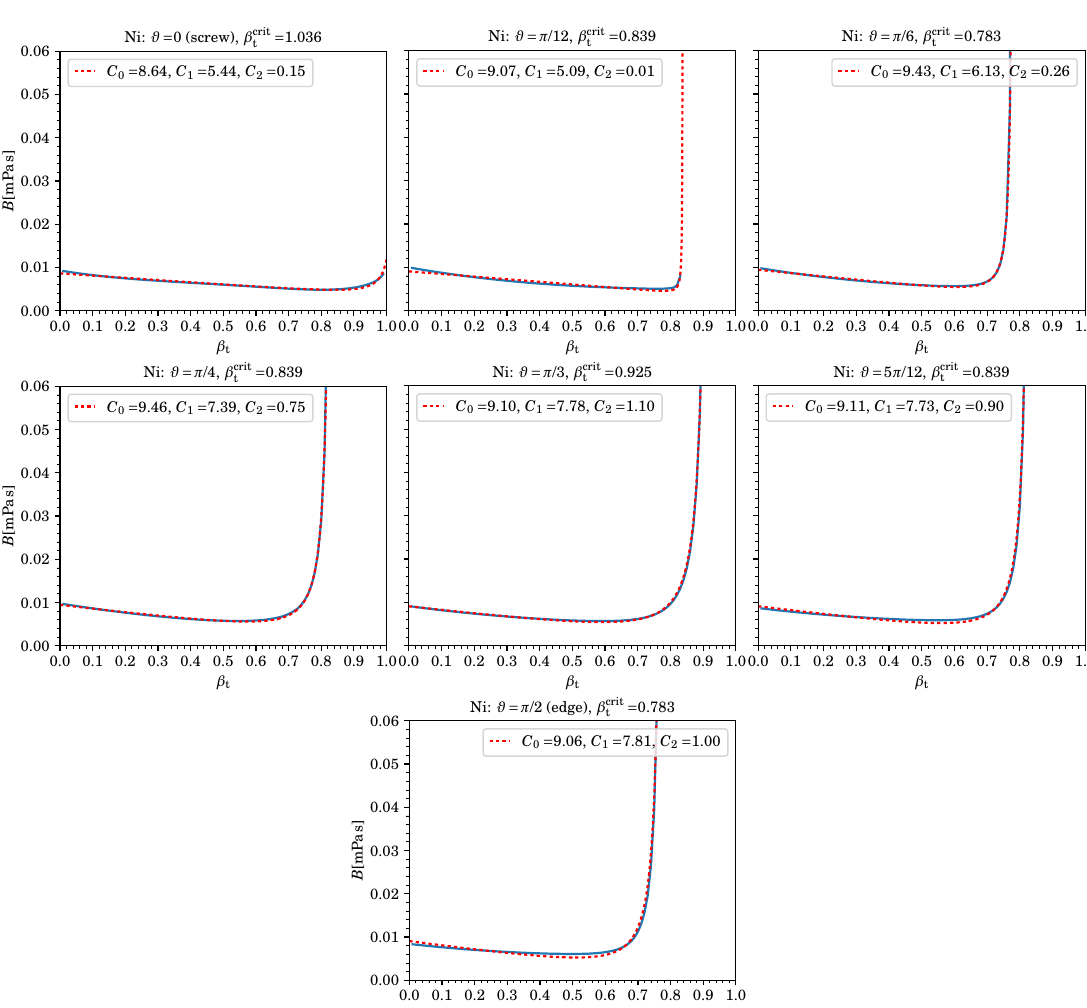
= v c / c = v / c T , and β T T . The solid lines show t